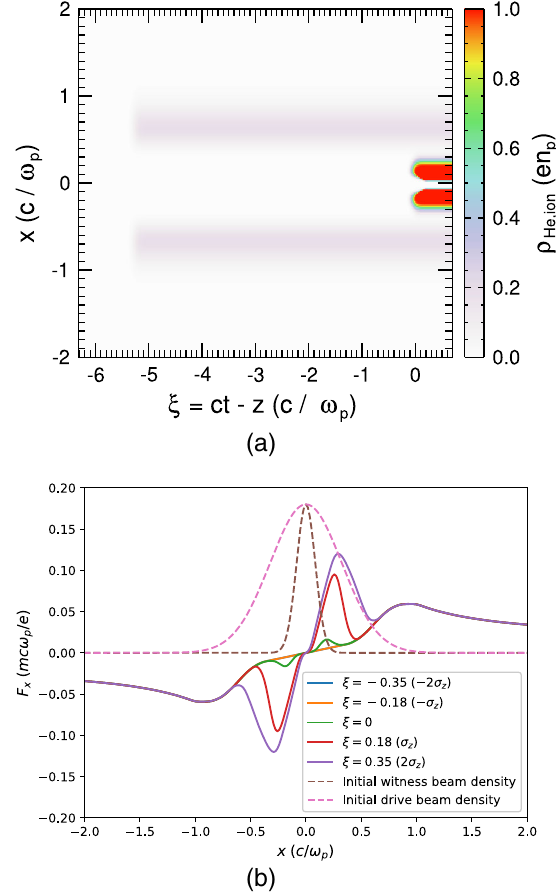
FIG. 9. (a) Helium ion charge density ρ . The grey area is He ; ion the helium ions produced by the drive beam, and the red area is the helium ions produced by the witness beam. (b) The F x transverse lineouts at different longitudinal positions, ξ , and the initial beam density profiles (in arbitrary